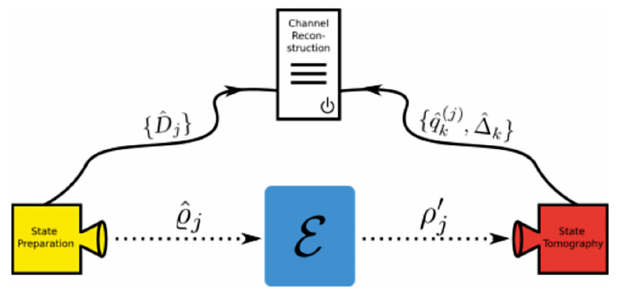
FIG. 9. Quantum process tomography. Any quantum channel E can be reconstructed by preparing a basis of input states and measuring the corresponding output states ρ (cid:10) an informationally complete POVM. The corresponding duals { ˆ D } , { ˆ (cid:18) } and the outcome probabilities then allow for the j k reconstruction of E according to Eq.